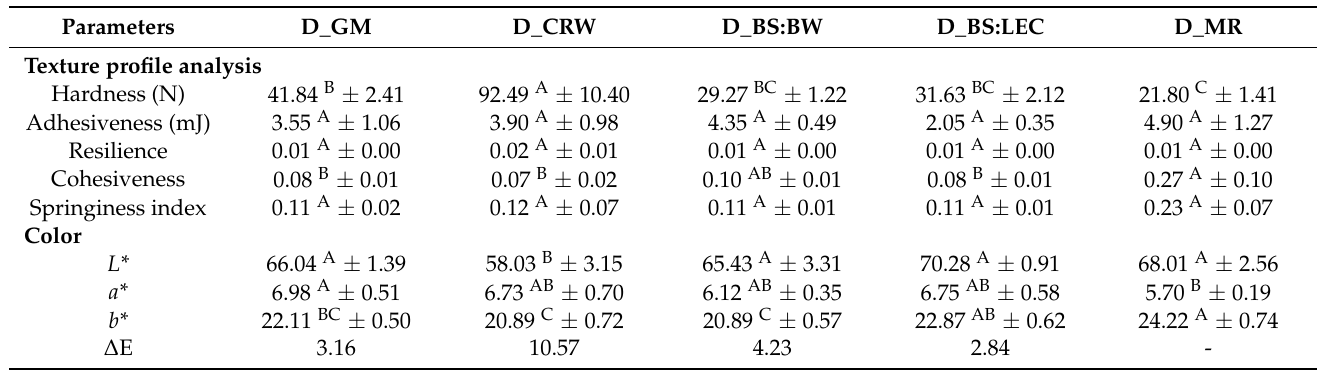
Table 2. Textural properties and color parameters of dough